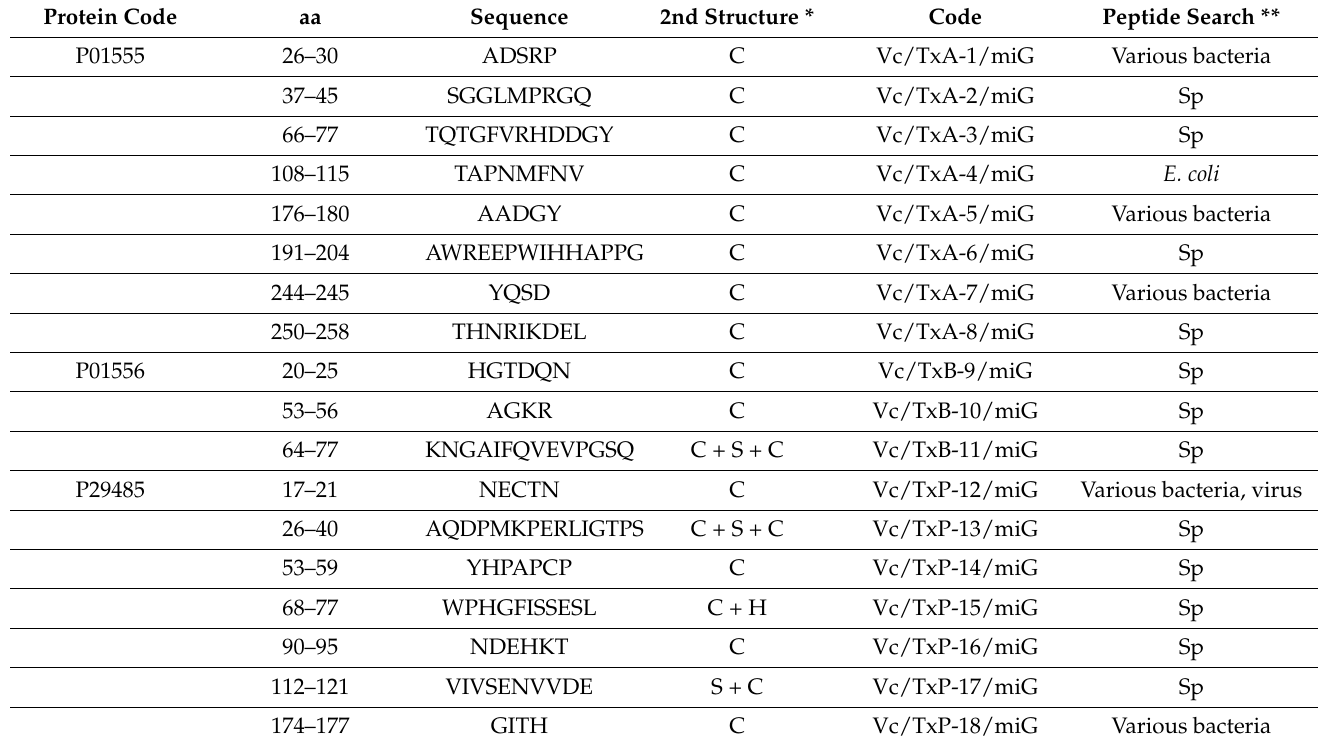
Table 1. List of B-cell linear IgG epitopes identified in TxA, TxB, and P deduced from the overlap of consecutive positive peptides with signal intensities greater than